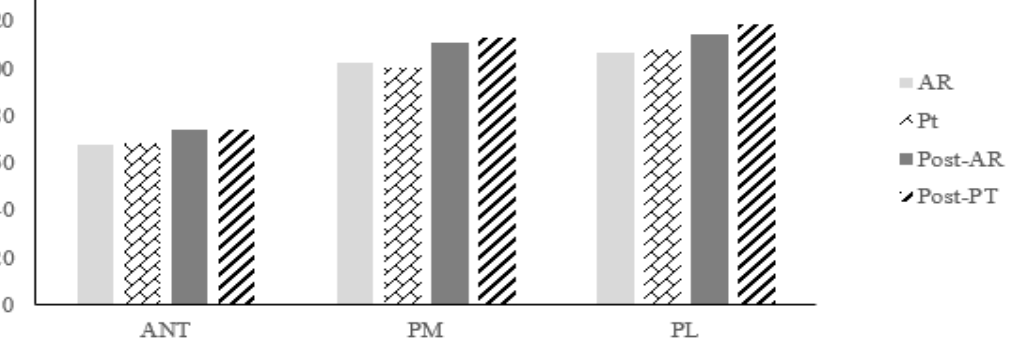
Figure 6. Comparison of dynamic balance between groups after intervention. AR: Pre-measurement of the experimental group; PT: Pre-measurement of the control group; Post-AR: Post-measurement of the experimental group; Post-PT: Post-measurement of the control group.